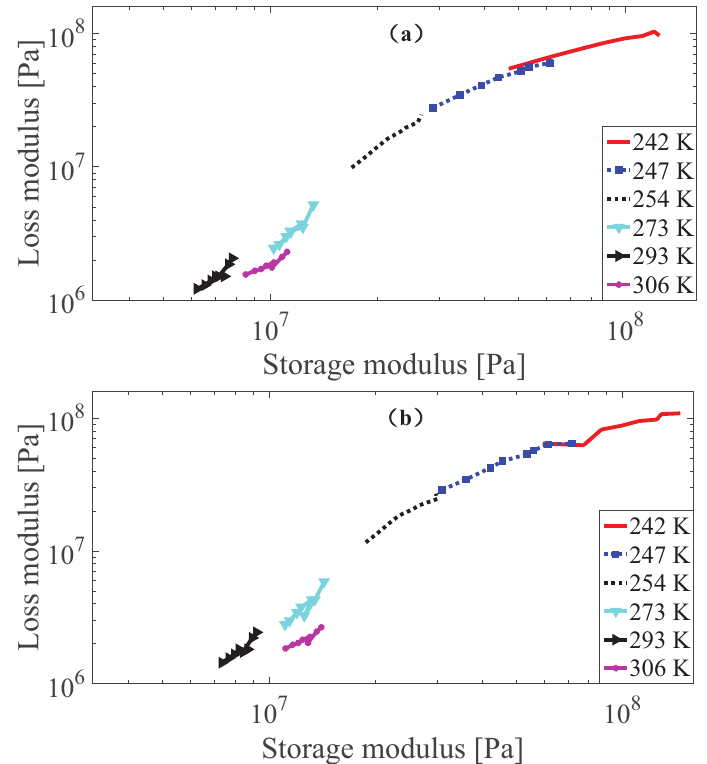
Figure 4. The Cole–Cole plot of dynamic shear modulus at 0.0015 strain amplitude with 0T ( a ) and 0.55T ( b ) under different temperatures.